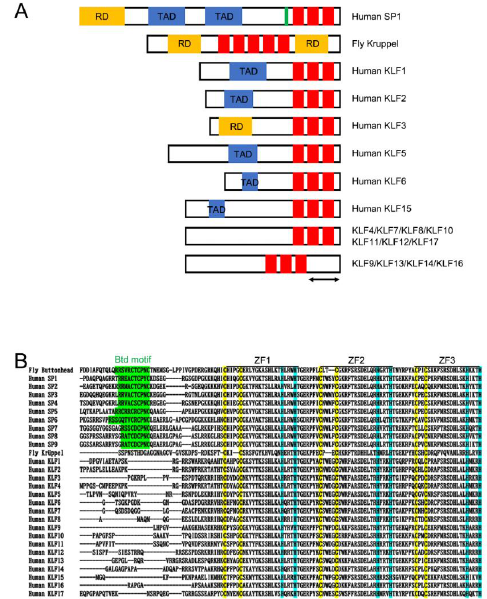
Figure 1. Structural and amino acid sequence properties of KLF proteins. ( A ) Structure of human SP1, Drosophila melanogaster (Fly) Krüppel, and human KLF proteins. TAD: transcriptional activation domain, RD: repression domain. The green region in SP1 protein defines the Buttonhead box motif, and red region defines the zinc finger motif. Most of the KLF proteins contain three zinc finger motifs close at the carboxyl-terminal edge, while KLF9, KLF13, KLF14, and KLF16 contain zinc finger motifs more positionally shifted to the middle part of the protein indicated by the double arrow. ( B ) Multiple sequence alignment of three zinc fingers and preceding amino-terminal amino acid residues of Drosophila melanogaster (Fly) Buttonhead, Krüppel, human SP1/KLF family proteins. The first three zinc finger sequences are shown for the Fly Krüppel protein. Alignment was generated by MAFFT, ClustalW, and visual inspection. Buttonhead box motifs (Btd motif) are highlighted by green color. Cystein and Histidine residues of the zinc finger motifs are highlighted by yellow and blue color,